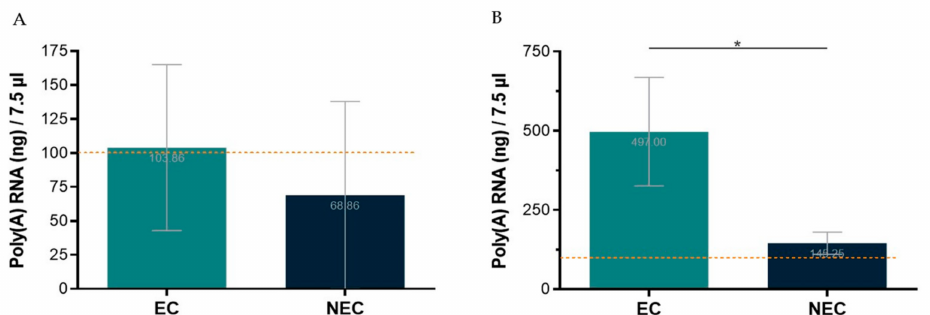
Figure 3. Poly(A) RNA isolation yield from embryogenic (EC) and non-embryogenic (NEC) cal- lus samples, in the maximum volume allowed to proceed to library preparation protocol. The dotted line represents the minimum threshold (100 ng/7.5 µ L) required for library